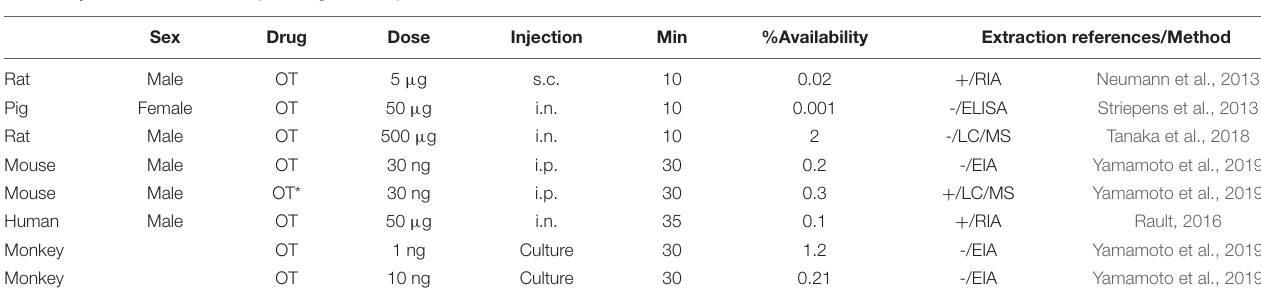
FIGURE 1 | Transportation of peripherally administrated oxytocin (OT) to the brain. Concentrations of OT in plasma (red) and cerebral spinal fluid (CSF) of the cisterna magna (blue) after subcutaneous injection of 30 ng OT (100 ng/mL × 0.3 mL) in wild-type ( RAGE + / + ) or RAGE KO ( RAGE − / − ) mice ( n = 3–16/data point, * P < 0.05 at time 0). The data shown are modified from Figure 4 of Yamamoto et al. (2019). OT was measured in un-extracted samples. TABLE 1 | Estimated bioavailability of exogenous oxytocin into the